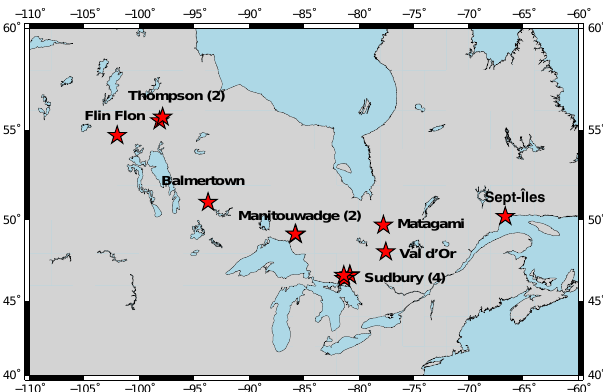
Figure 1. Map of central and eastern Canada and adjoining USA showing the location of sampled boreholes. Thompson (Owl and Pipe), Manitouwadge (0610 and 0611) and Sudbury (Falconbridge, Lockerby, Craig Mine, and Victor Mine) have several boreholes present within a small region. The number of profiles available at locations with multiple holes is enclosed in